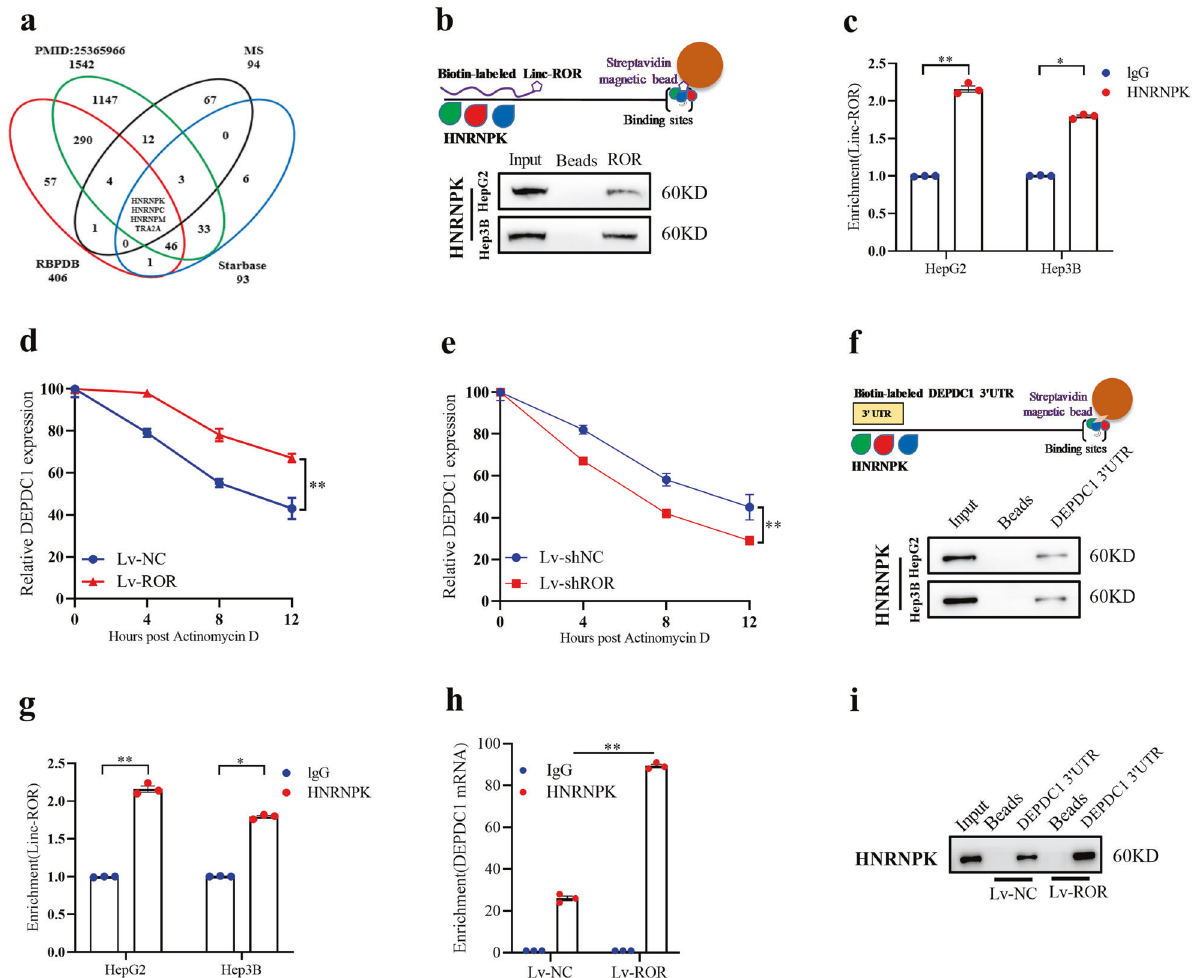
Fig. 5 Linc-RoR speci fi cally regulates DEPDC1 by facilitating the interaction of HNRNPK with DEPDC1 mRNA. a Venn diagram showing the RNA-binding protein shared in RBPDB, Starbase database, MS-protein and PMID:25365966. b The schematic diagram of the RNA pull-down method used to identify the binding between Linc-ROR and RNA-binding protein in both HepG2 and Hep3B cells; interaction of Linc-RoR with HNRNPK, as detected by RNA precipitation using Linc-RoR as an RNA probe, followed by western blot. c RIP assay using HNRNPK antibody con fi rms that Linc-RoR interacts with HNRNPK. d Increase of DEPDC1 mRNA stability in Lv-RoR cells as compared to control cells. Cells were treated with 2.5 μ g/mL actinomycin D and RNA was isolated at 0, 4, 8 and 12 h, respectively. e Re-expression of Lv-shRoR restores its ability to decrease DEPDC1 mRNA stability. f The schematic diagram of the RNA pull-down method used to identify the binding between DEPDC1 and RBP in both HepG2 and Hep3B cells; interaction of DEPDC1 with HNRNPK, as detected by RNA precipitation using DEPDC1 as an RNA probe, followed by western blot. g RIP assay using HNRNPK antibody con fi rms that DEPDC1 interacts with HNRNPK. h Linc-RoR is required for the interaction of HNRNPK with DEPDC1 mRNA, as detected by RIP assay using HNRNPK antibody. i Linc-RoR enhances the interaction of DEPDC1 mRNA with HNRNPK, as detected by RNA precipitation using DEPDC1 3 ʹ -UTR probe. Data are shown as mean ± SD, n = 3. The data statistical signi fi cance is assessed by Student ’ s t test. * P < 0.05, ** P < 0.01, *** P <